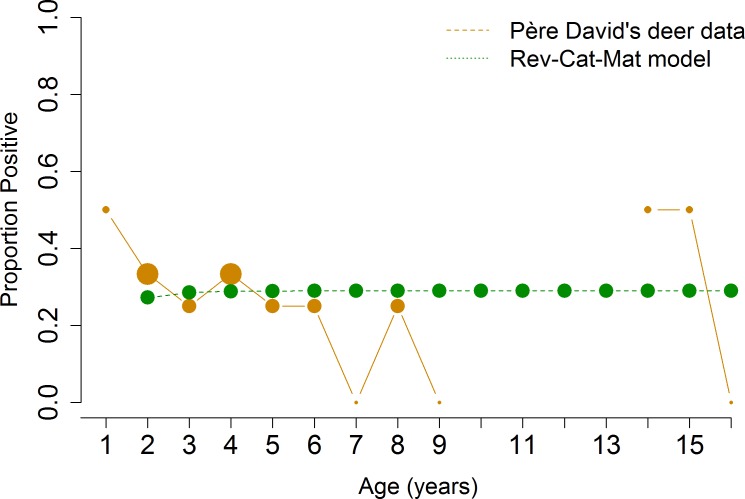
Model selection for Père David’s deer.Reverse catalytic model with maternal antibodies was the best-fit model for Père David’s deer. Size of points represents the relative number of animals sampled with that age.